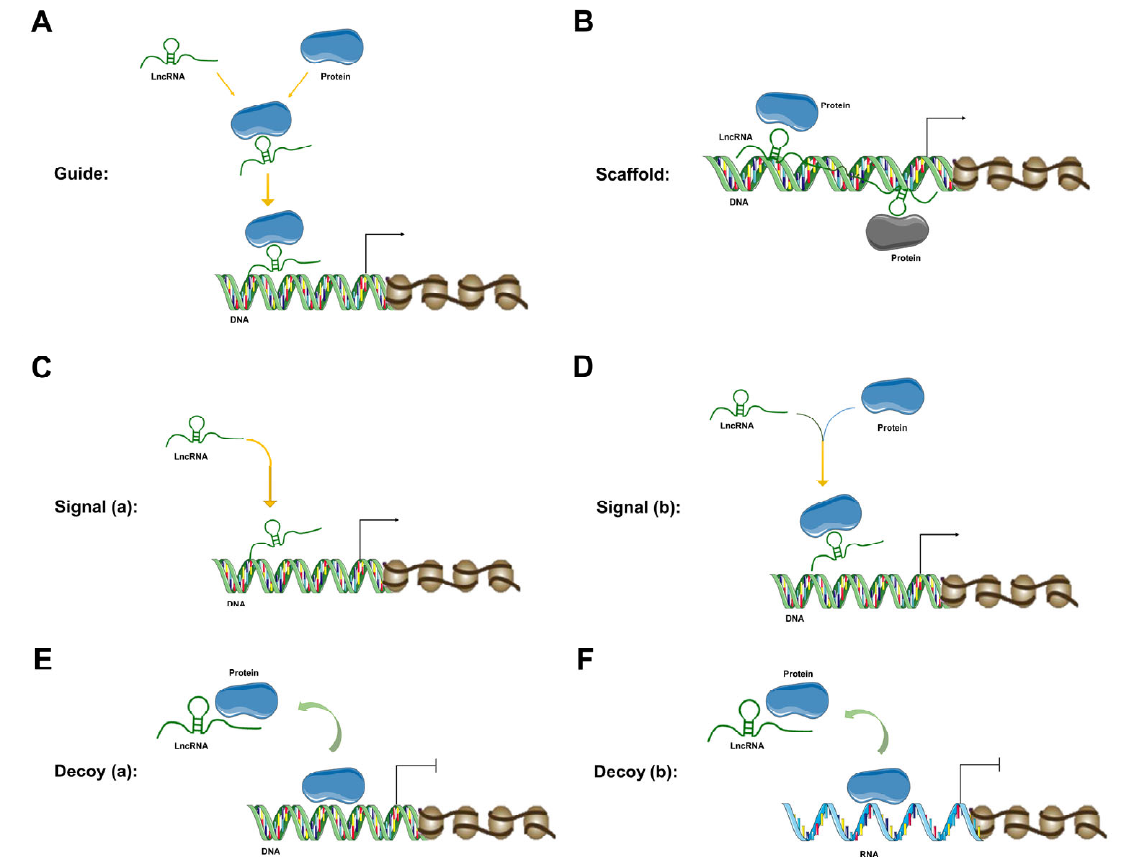
Figure 1. LncRNA mechanisms of action. ( A ) LncRNA is working as a guide molecule to guide protein recruitment to its desired location to facilitate epigenetic modification. ( B ) LncRNA is working as a scaffold to provide the proteins with a structural framework. ( C ) LncRNA is working as a signal molecule (without any protein) to regulate the transcription of downstream genes. ( D ) LncRNA is working as a signal molecule (along with a protein) to regulate the transcription of downstream genes. ( E ) LncRNA is working as a decoy (for a DNA molecule) to regulate the transcription of downstream genes. ( F ) LncRNA is working as a decoy (for an RNA molecule) to regulate the transcription of downstream genes.